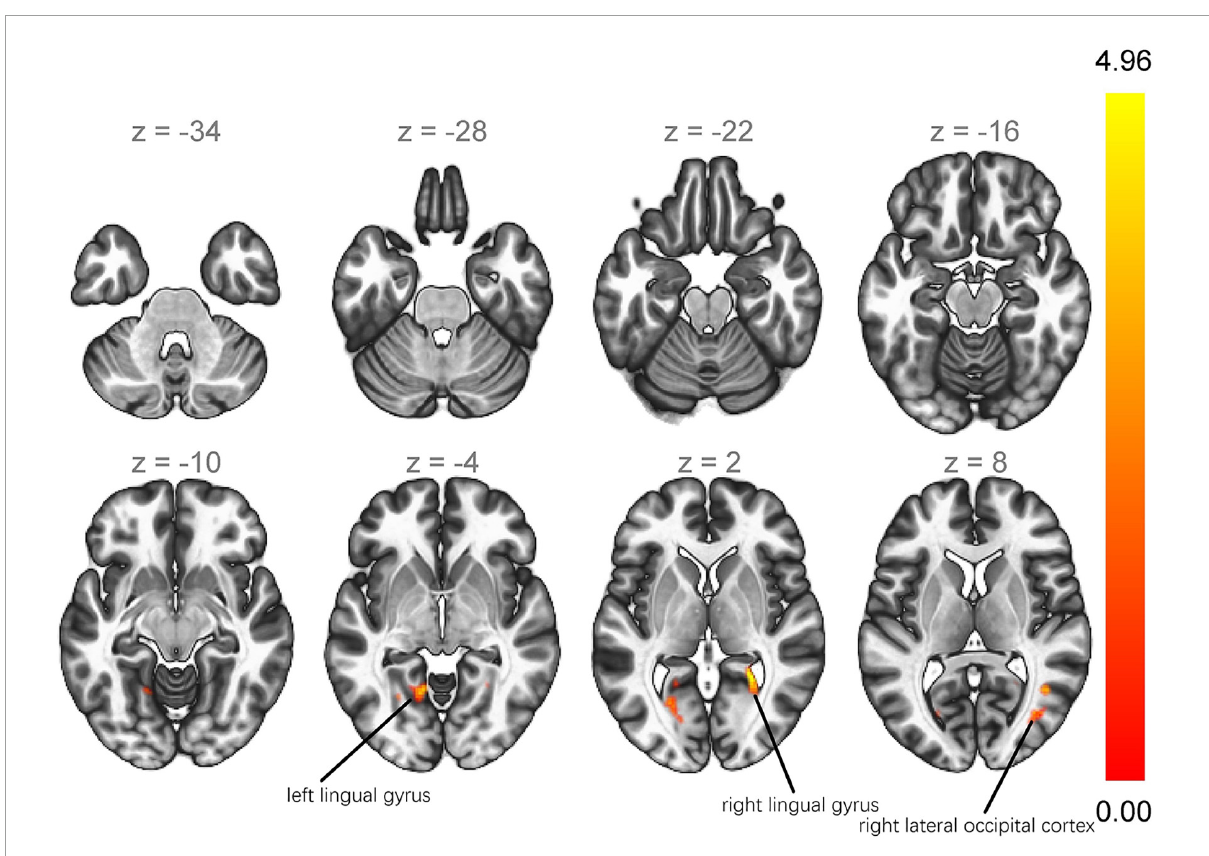
FIGURE2 Seed-to-voxel analysis showing greater functional connectivity of the right superior frontal gyrus with the left lingual gyrus, right lateral occipital cortex, and right lingual gyrus in PIGD patients than in TD patients. PIGD, postural instability/gait difficulty; TD,